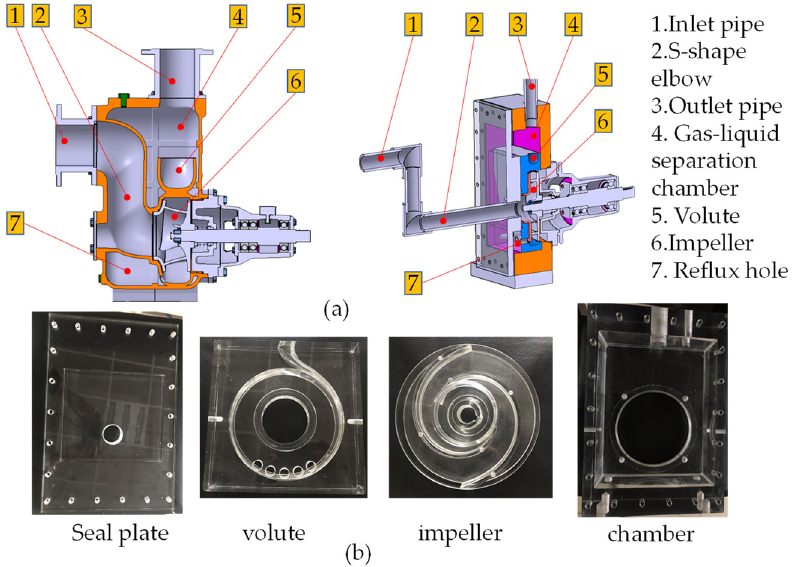
Figure 1. Test pump structure. ( a ) Comparison of critical fluid domains between actual product and the test pump; ( b ) transparent part of the test pump.